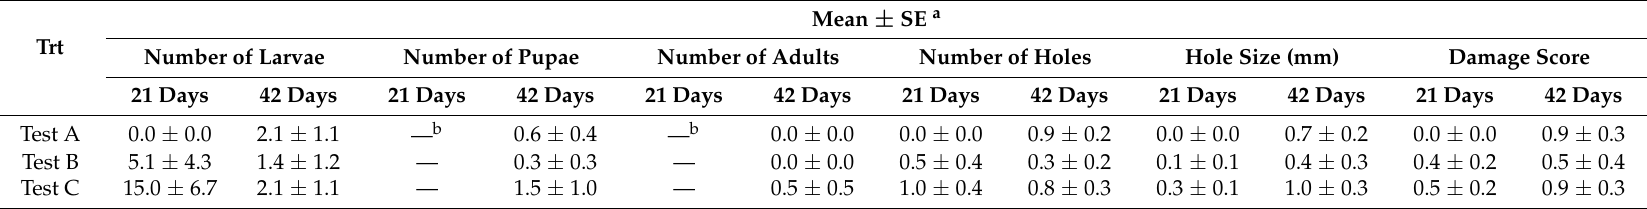
Table 4. Number of larvae, pupae, and adults of P. interpunctella found inside packages of energy bars in treatments with two mating pairs after 21 days and 42 days of infestation, and the extent of damage to packages and energy